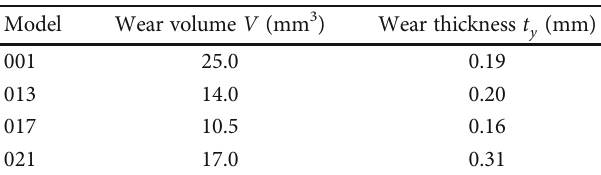
Table 4: Theoretical calculation results of wear thickness of each fi nger